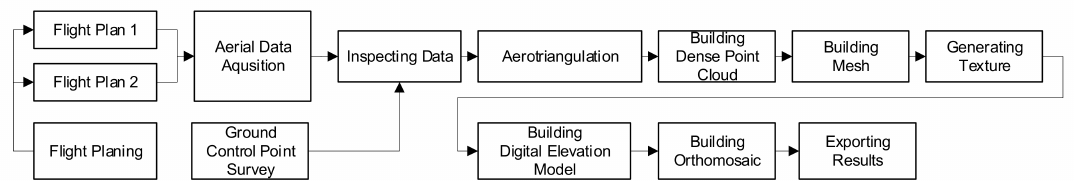
Figure 2. The unmanned aerial vehicle (UAV) photogrammetry process.